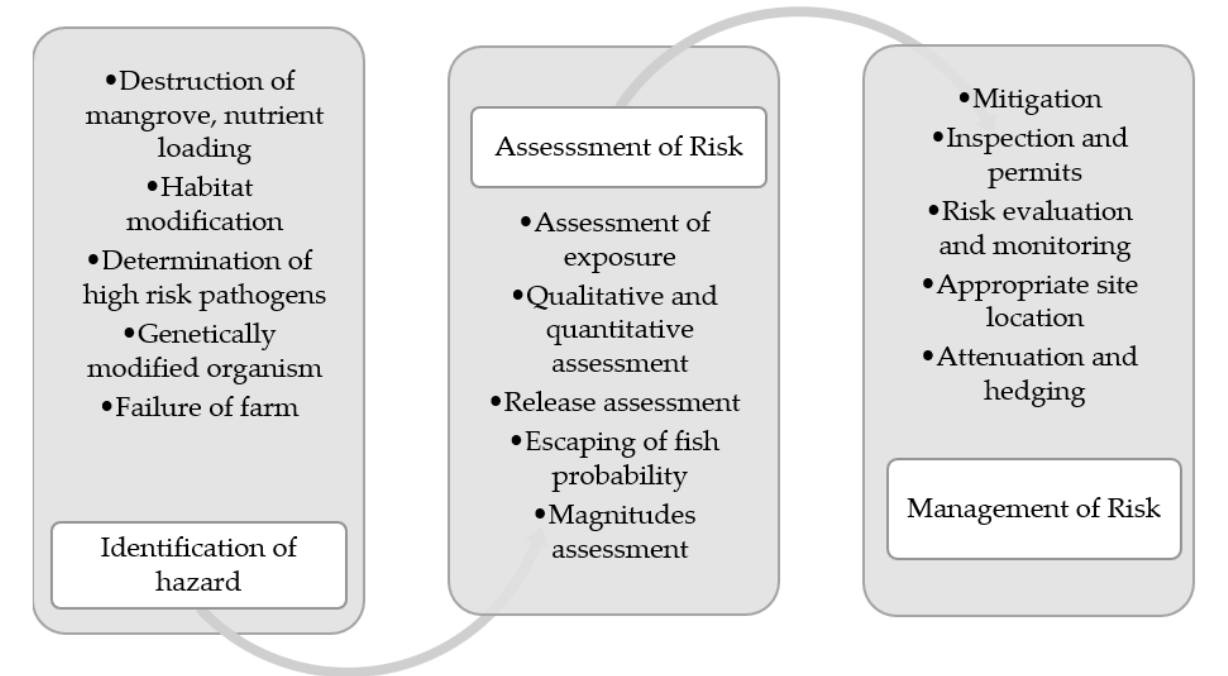
Figure 2. Risk analysis application towards achieving sustainability in aquaculture.